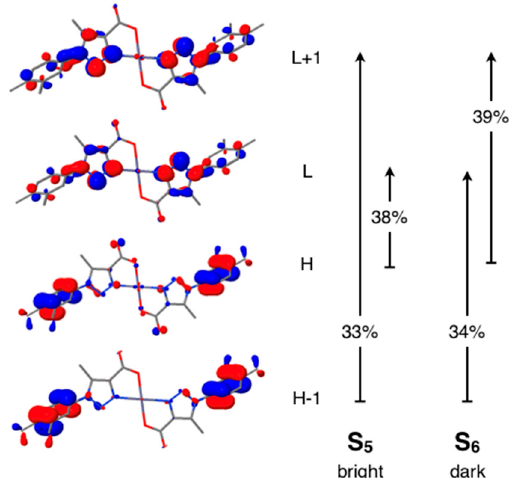
Figure 10. Frontier orbitals and main amplitudes for the S 5 and S 6 states for the ZnL 2 (H 2 O) 2 fragment with the geometry obtained from the X-ray structure.